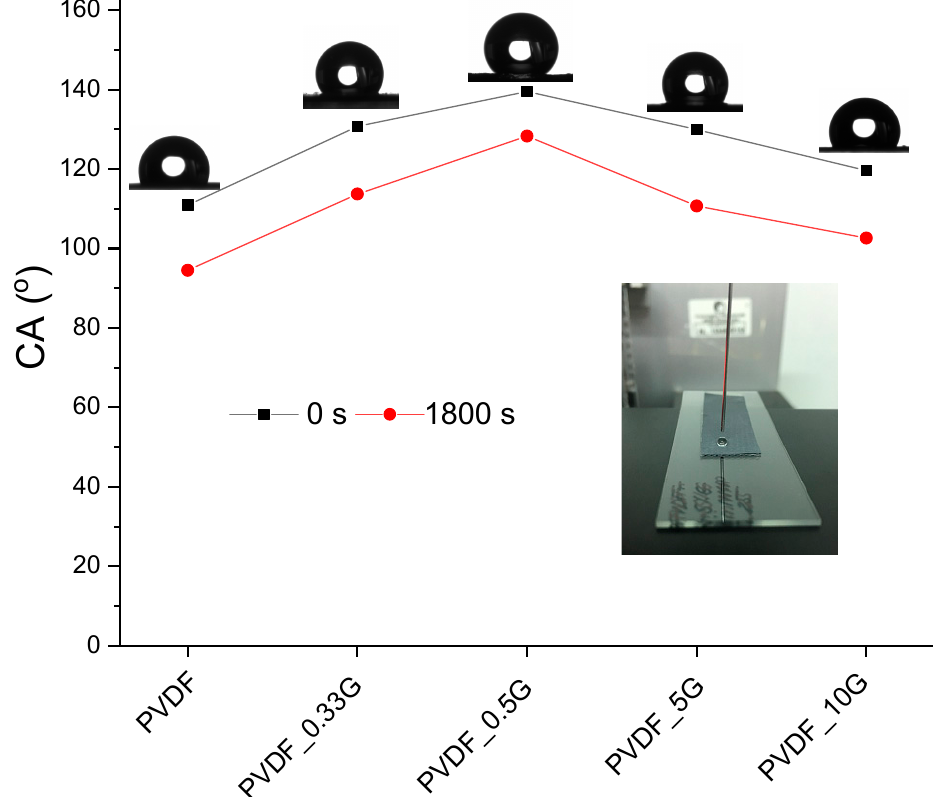
Figure 2. Water contact angle values for pristine PVDF membrane and its graphene-based composites.